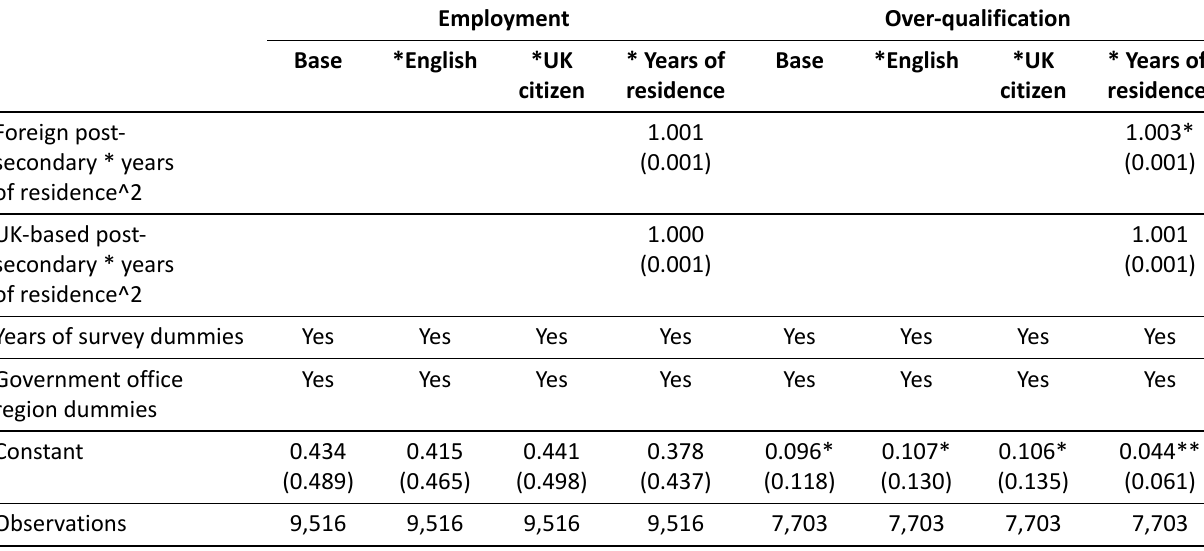
Table A5. (Cont.) Binary logistic regression model with sequential interactions of post-secondary qualifications for men.